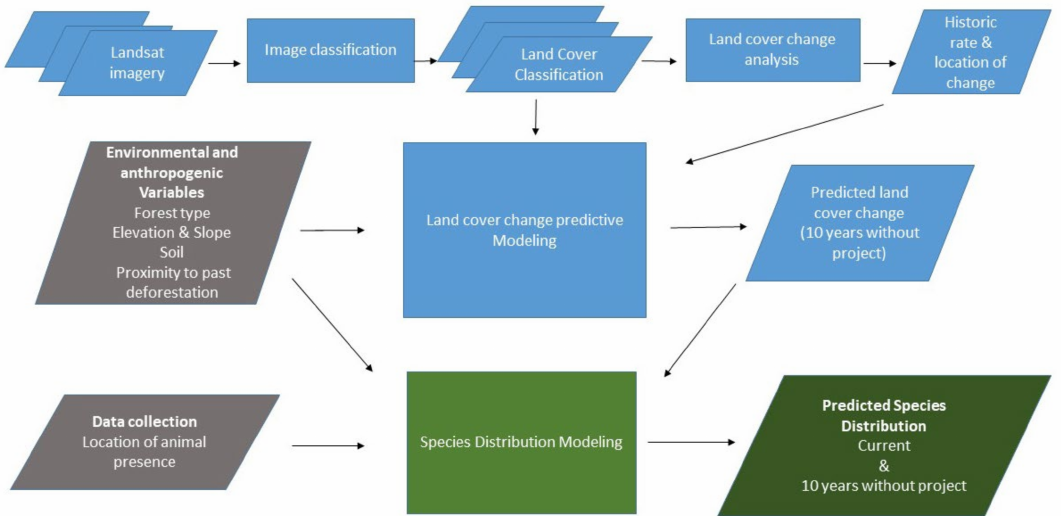
Figure 2. Data sources and processing flow. Blue components are all required for REDD project development. The green components are additional analyses used for Climate, Community and Biodiversity Standard (CCB)